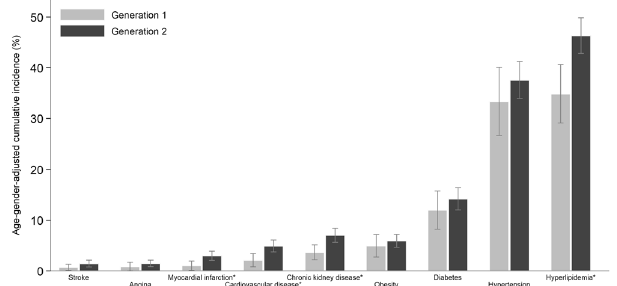
Figure 1. 6-year cumulative incidence (age and gender adjusted) of CVD and related conditions in first- and second-generation Indians in Singapore. Asterisk indicates statistical significance between generations (p < 0.05). Error bars represent 95% confidence